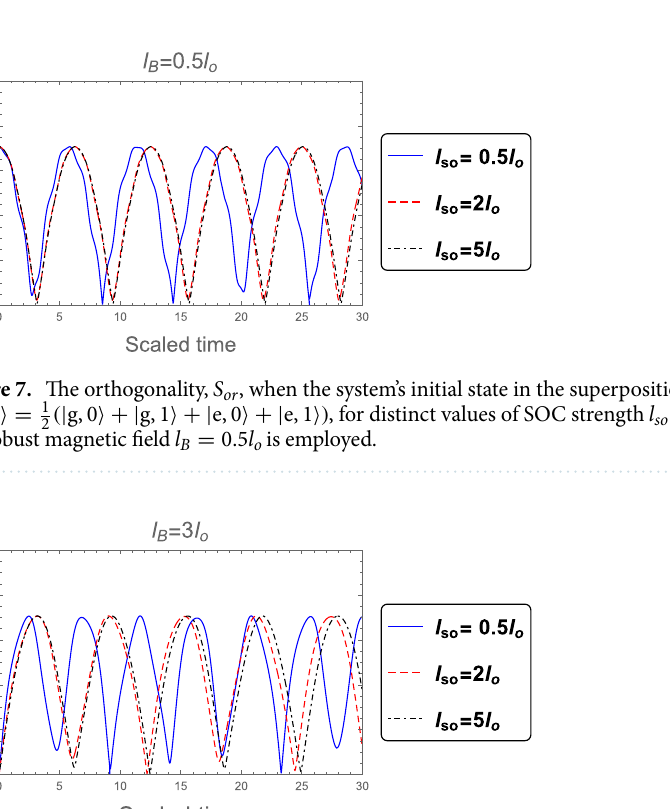
Figure 8. As Fig. 7, but when the weak magnetic field l B